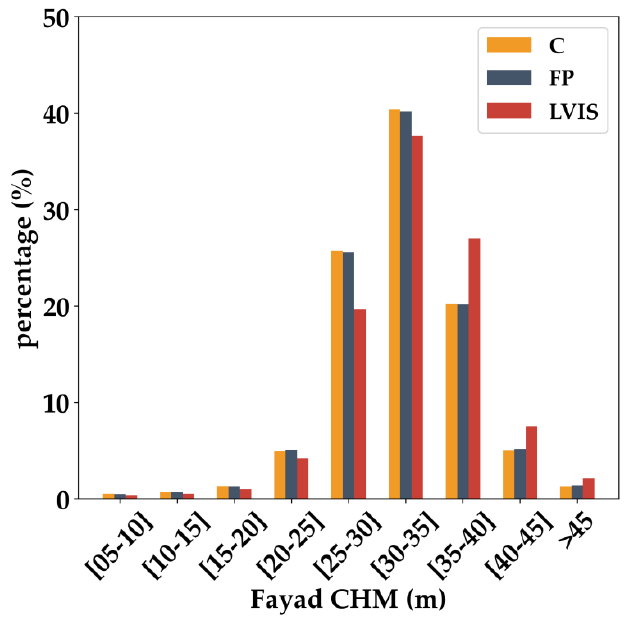
Figure 2. Distribution of canopy heights from Fayad’s map over GEDI’s coverage (“C”), and full- power (“FP”) laser footprints, and LVIS